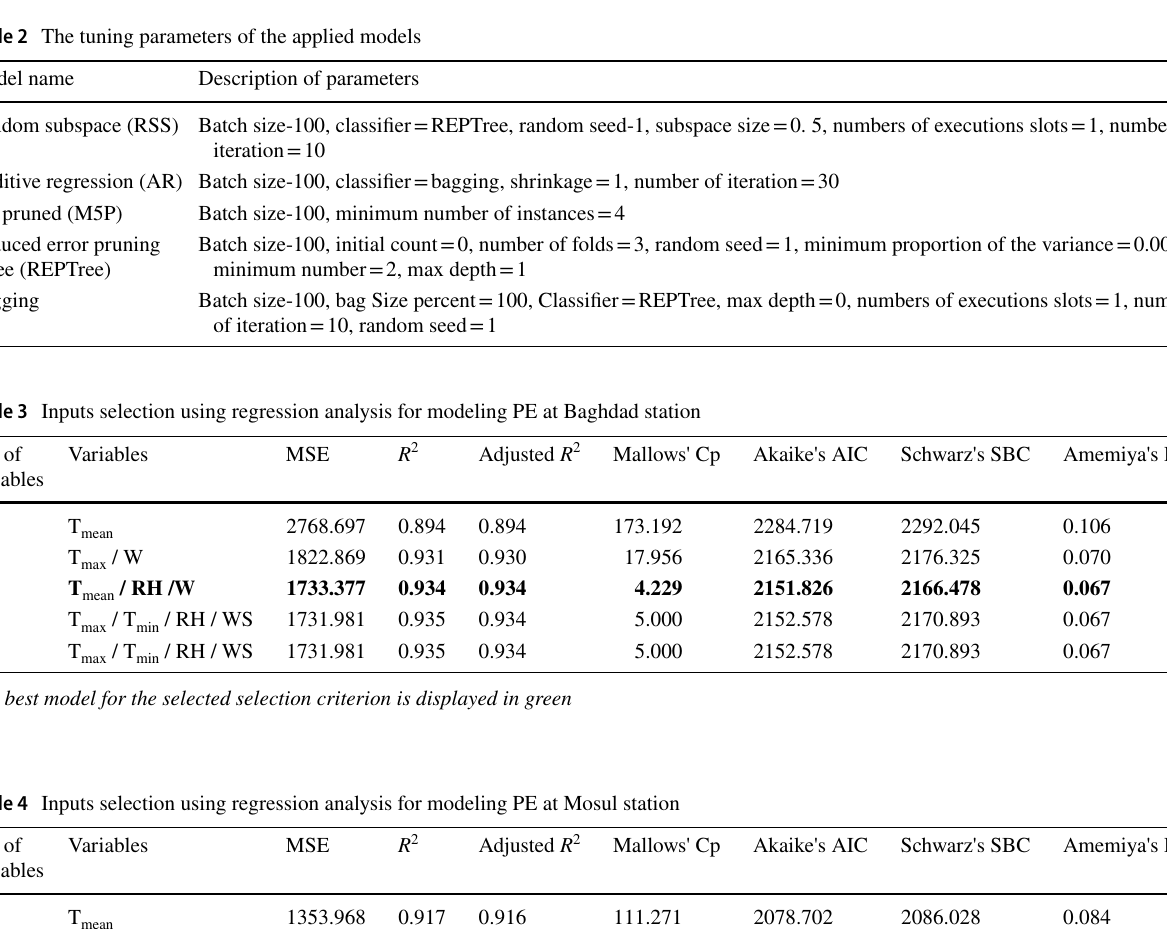
Table 2 The tuning parameters of the applied models Model name Description of parameters